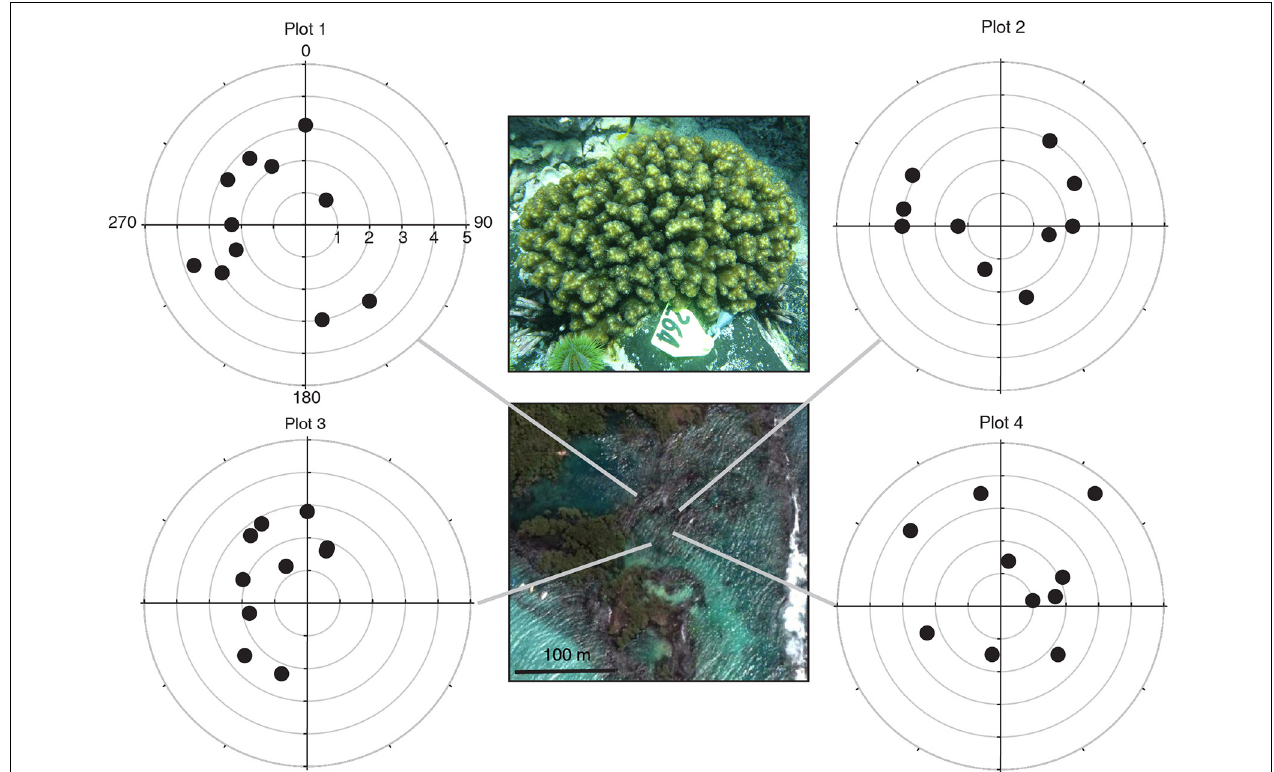
FIGURE 1 | Pocillopora colonies were sampled in four polar plots within the volcanic pools at Concha Y Perla, Isabela Island, Galápagos. All colonies shared the same host multilocus genotype (indicated by the symbol shape) and harbored Symbiodinium ITS-2